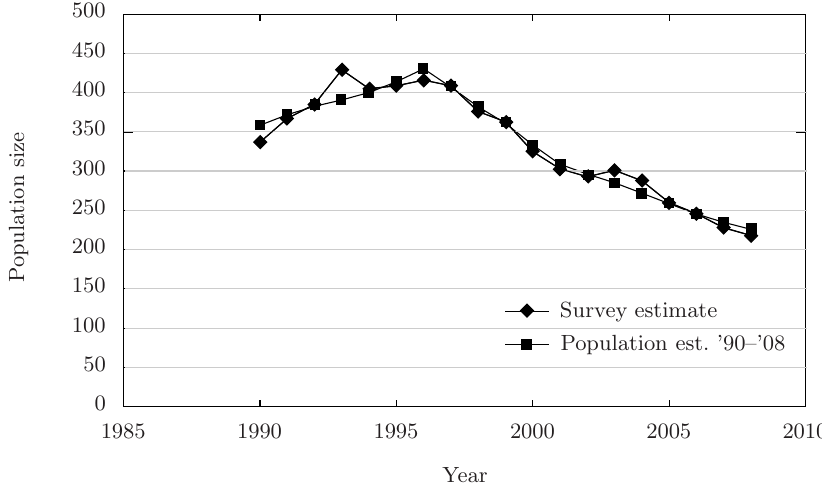
Figure 6: Black rhino surveys and population size estimates from 1990–2008, two growth